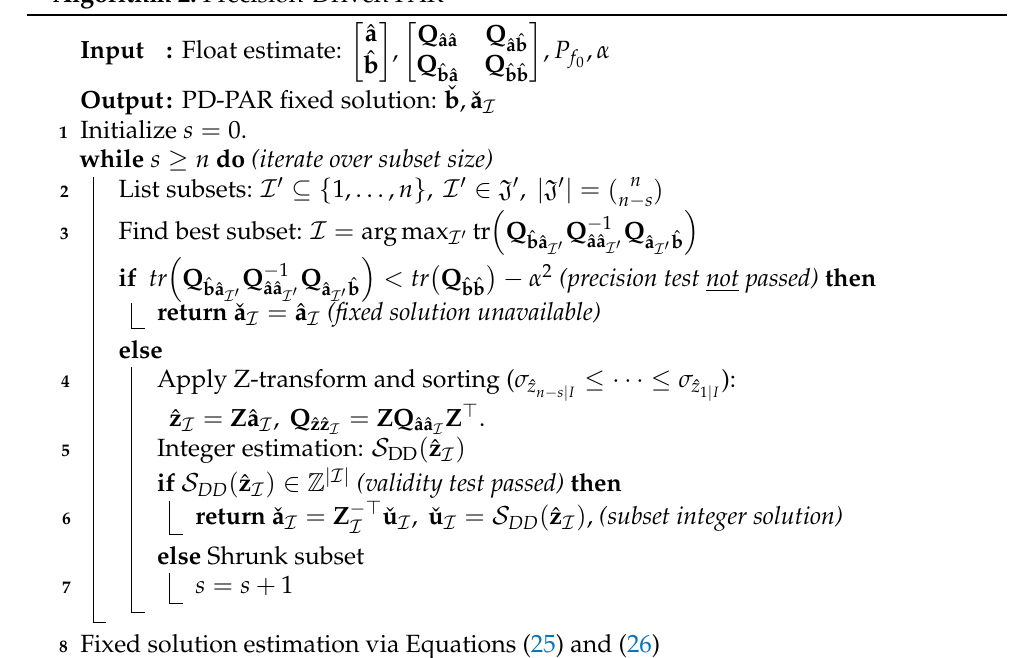
Algorithm 2 proposes a top-bottom (the number of ambiguities to integer-map de- creases with the iterations) workflow for PD-PAR, with ( n